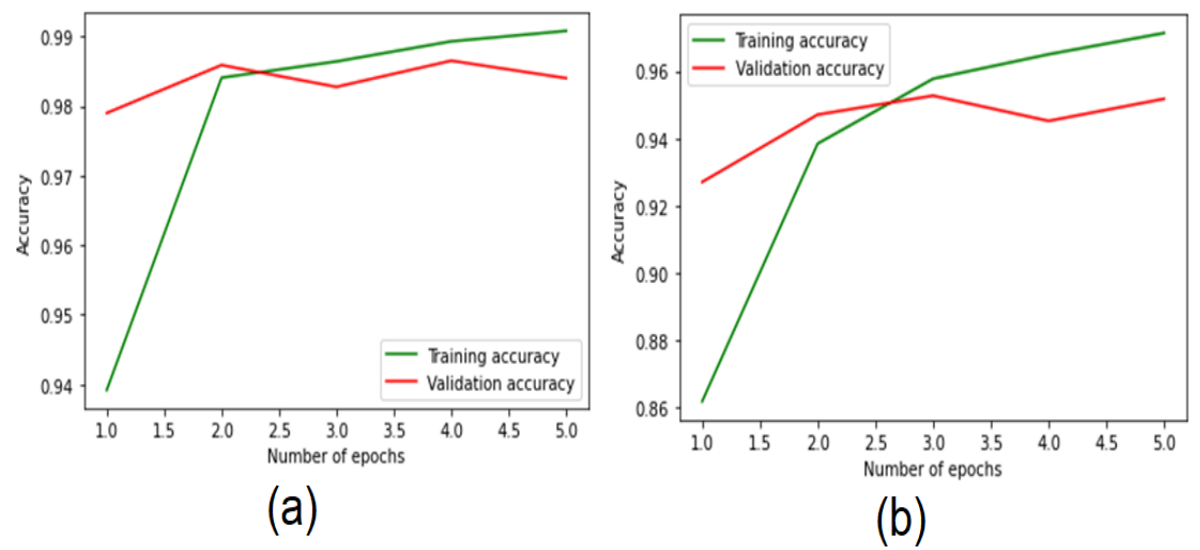
Figure 11. Performance plots o for the multiclass classification dataset ( a ) BiLSTM ( b ) CNN-BiLSTM.